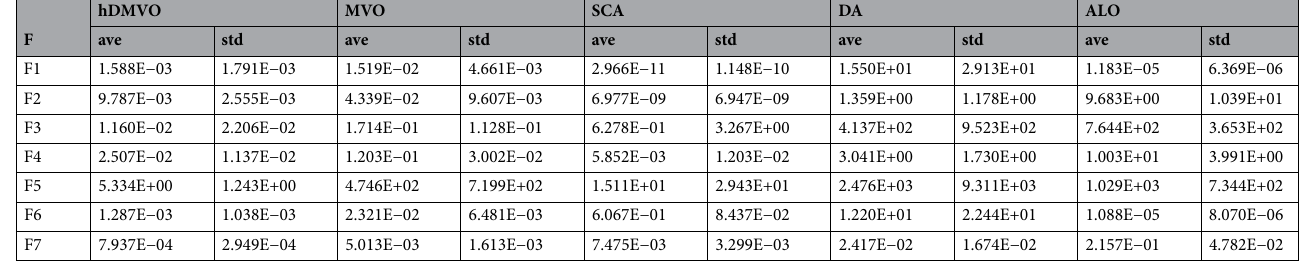
Table 5. Results of unimodal benchmark